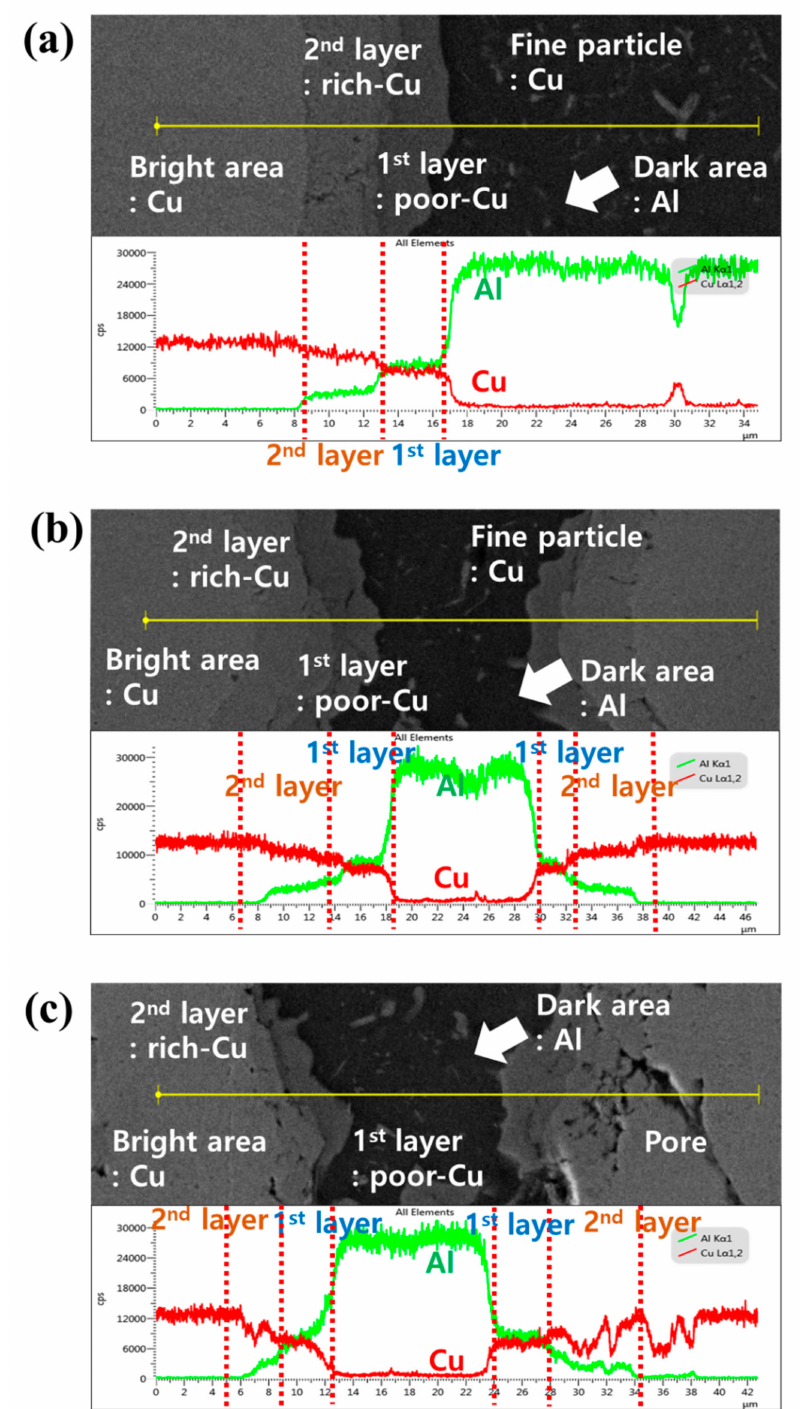
Figure 5. SEM micrograph and energy-dispersive spectroscopy (EDS) line scanning results along the yellow line for ( a ) Al–20Cu, ( b ) Al–50Cu, and ( c )